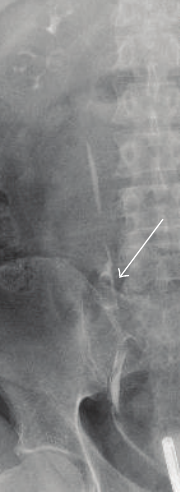
Figure 1: Retrograde pyeloureterography revealing right mid- ureteral filling defect.